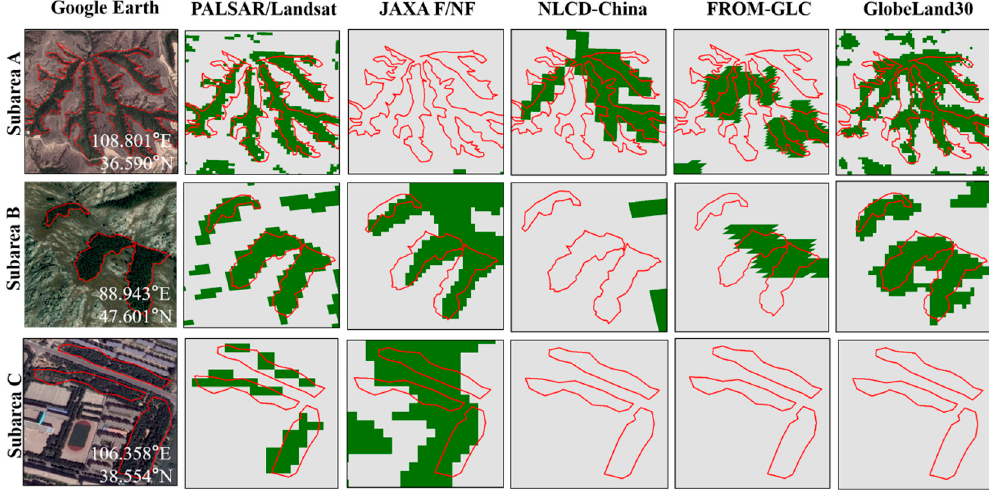
Figure 7. Qualitative comparison between VHR images in Google Earth, PALSAR/Landsat-based forest map, and the other four forest products in three randomly chose subareas. The red polygons represent the forest patches interpreted visually based on Google Earth. The coordinates refer to the center of the subareas. Subarea A: 2.25 km 2 , Subarea B: 0.50 km 2 , Subarea C: 0.11 km 2 .